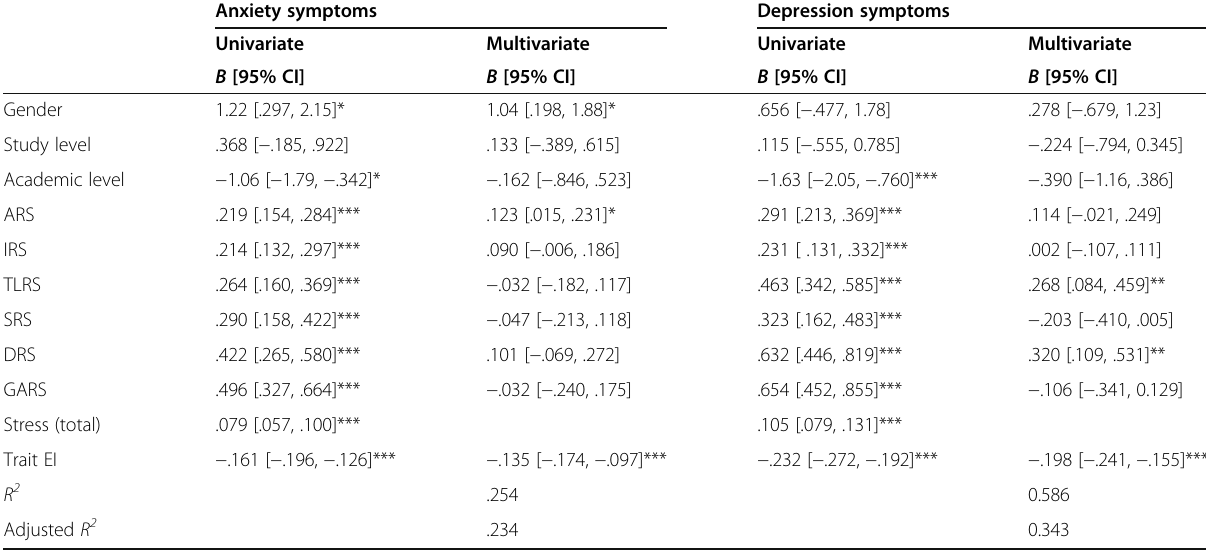
Table 5 Hierarchical regression analysis for predicting anxiety and depression symptoms by exposure to stress ( N =